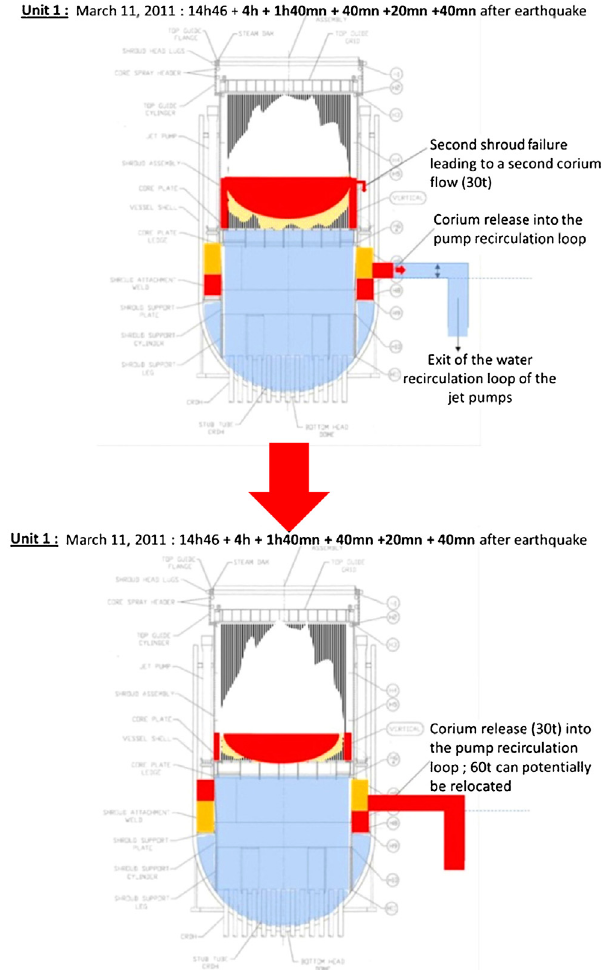
Fig. 7. Illustration of the secondary shroud failure from the core annulus pool: ∼ 7 h 20 after the reactor shutdown.